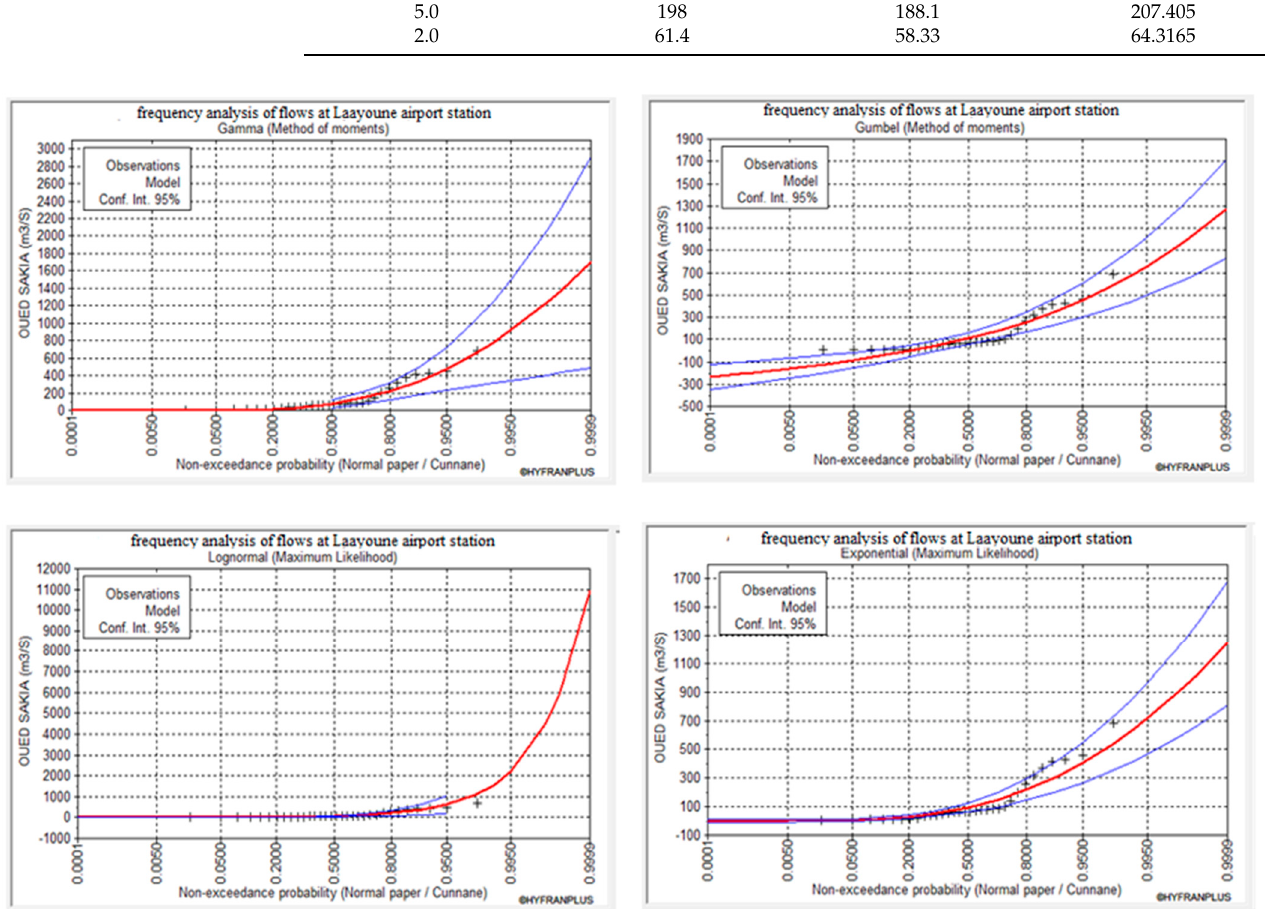
Figure 10. Adjustments of the static laws on the annual maximum daily flows.